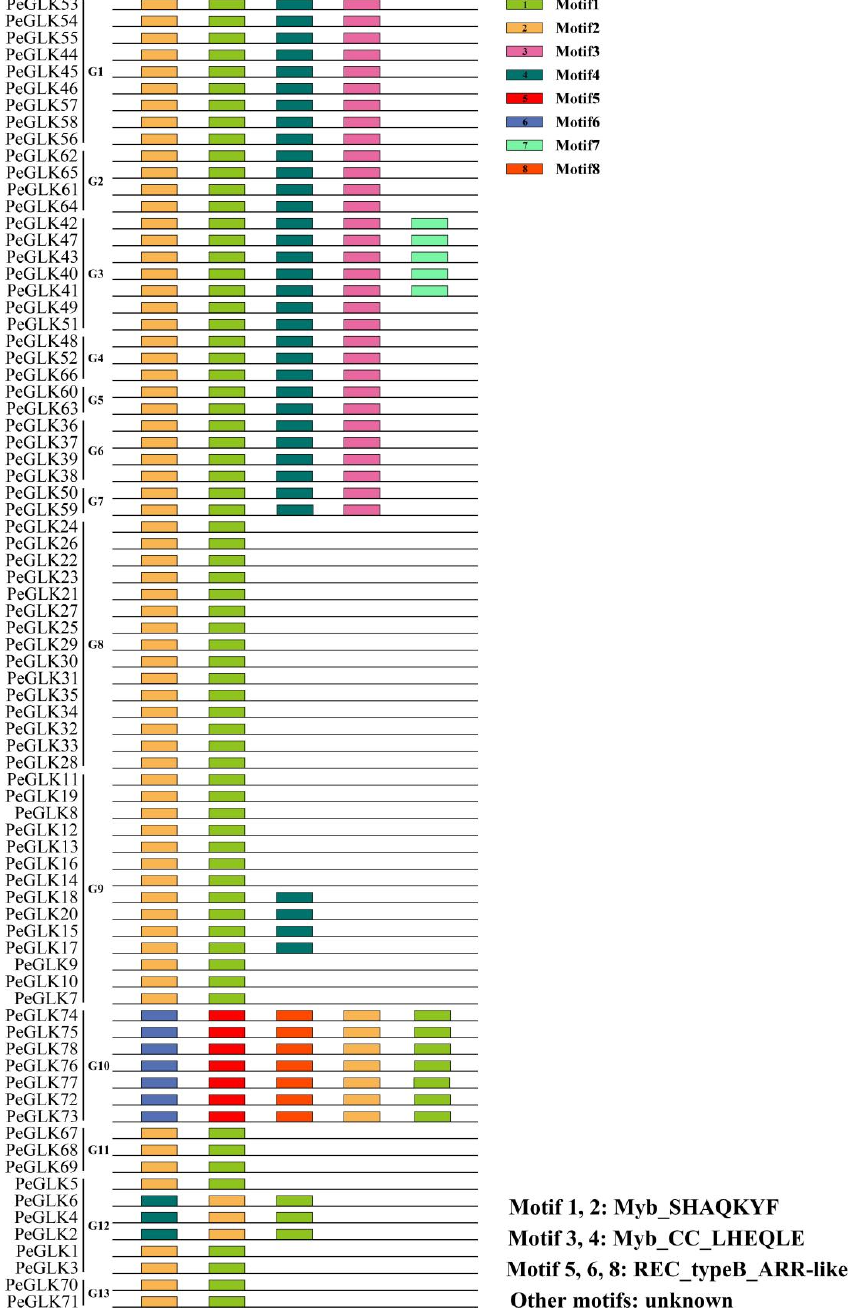
Figure 4. Schematic representation of eight conserved motifs (1–8) in PeGLKs, ordered based on online MEME analysis. Lengths of motifs are displayed proportionally.